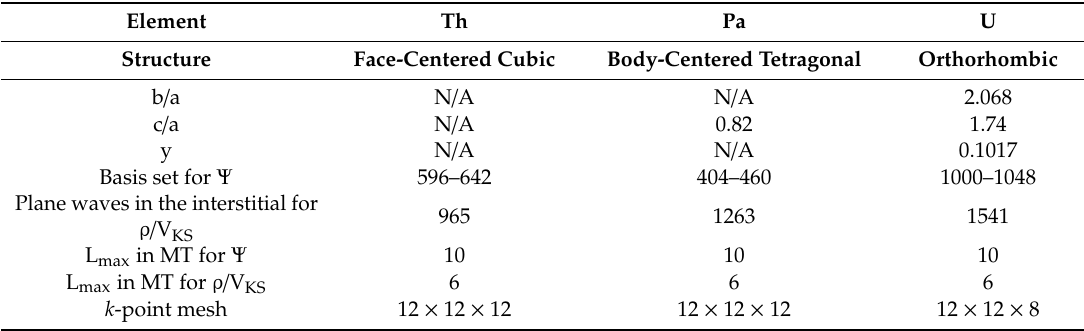
Table 1. Structural parameters and cut-o ff s for the calculations with FlapwMBPT. Ψ represents the wave function, ρ the electronic density, and V KS the Kohn–Sham potential. Basis-set size corresponds to the fully relativistic calculations. For the scalar-relativistic approach, the size is half. Element Th Pa U Structure Face-Centered Cubic Body-Centered Tetragonal Orthorhombic b / a N / A N / A 2.068 c / a N / A 0.82 1.74 y N / A N / A 0.1017 Basis set for Ψ 596–642 404–460 1000–1048 Plane waves in the interstitial for 965 1263 1541 ρ / V KS L max in MT for Ψ 10 10 10 L max in MT for ρ / V KS 6 6 6 k -point mesh 12 × 12 × 12 Table 2. Density-functional-theory relative expansion (%) of the atomic volume due to inclusion of spin–orbit (SO) coupling, (V SO -V No-SO ) / V SO . For full-potential linear augmented plane-wave (FPLAPW), SO is included exactly via the Dirac equation, while for full-potential linear mu ffi n-tin orbital (FPLMTO) and Vienna ab initio simulation package (VASP), a scalar-relativistic basis set is used with perturbative SO that is ignored for the p states. For plutonium, orbital polarization is important and therefore included. Element FPLAPW FPLMTO VASP Th 0.12 0.53